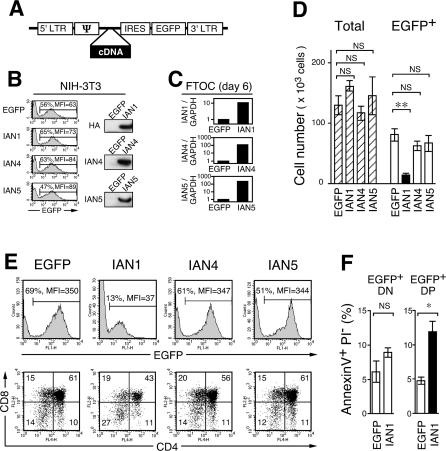
Overexpression of IAN1, IAN4, and IAN5 in Thymocyte Development(A) Diagram of MSCV retroviral constructs.IRES, internal ribosomal entry site; LTR, long terminal repeat; Ψ, packaging signal.(B) NIH-3T3 cells infected with retroviruses expressing IAN1-HA, IAN4, IAN5, or EGFP alone were analyzed for EGFP fluorescence by flow cytometry and for IAN protein expression by immunoblotting (IB). The frequency of cells and the mean fluorescence intensity (MFI) in the indicated area are shown.(C) Day 14.5 fetal thymocytes infected with indicated retroviruses were reconstituted in FTOC. EGFP
+ cells purified on day 6 were analyzed for mRNA expression.
(D) Viable cell numbers of total cells (striped bars) and EGFP
+ cells (open bars) in FTOC on day 6. Filled bar indicates a significant reduction (
p < 0.01). EGFP,
n = 7; IAN1,
n = 6; IAN4,
n = 6; IAN5,
n = 6.
(E) EGFP histograms of total cells and CD4/CD8 profiles of EGFP
+ cells in FTOC on day 6. Numbers in dot plots show the frequency of cells within boxes.
(F) Annexin V and PI staining of indicated EGFP
+ thymocyte subpopulations in FTOC on day 6. Filled bar indicates a significant increase (
p < 0.05).
Bar graphs show means ± standard errors.NS, not significant (
p ≥ 0.05); *
p < 0.05; **
p <0.01. No significant difference in the CD4/CD8 developmental profiles was observed in EGFP
− cell populations.